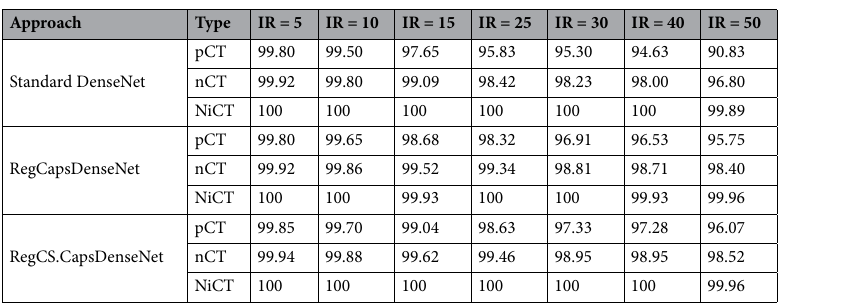
Table 3. F1-Score evaluation (%) of our developed deep networks on the HUST dataset in various imbalanced conditions.